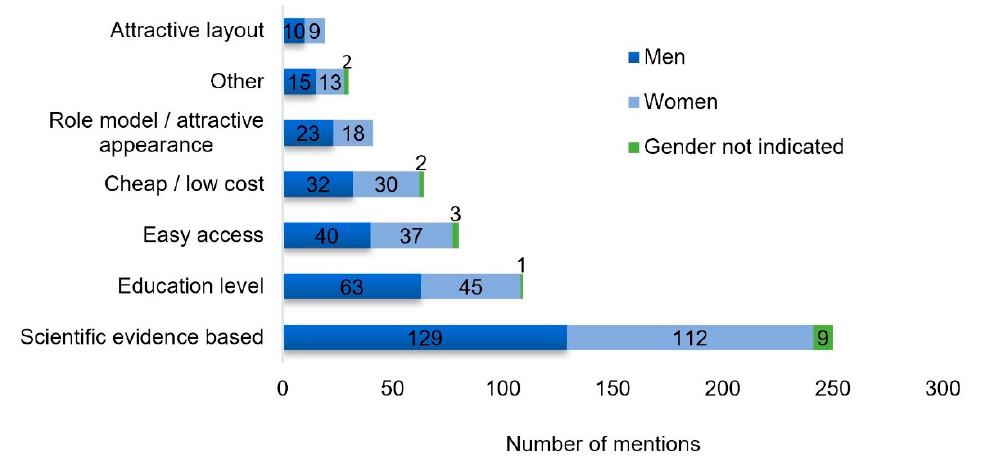
Figure 5. Reasons for information source selection. No significant gender effects ( p < 0.05).